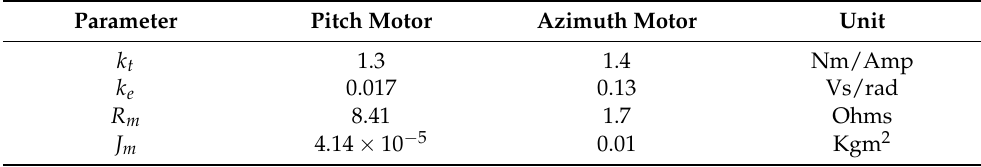
Table 1. The electrical parameters of the two DC torque